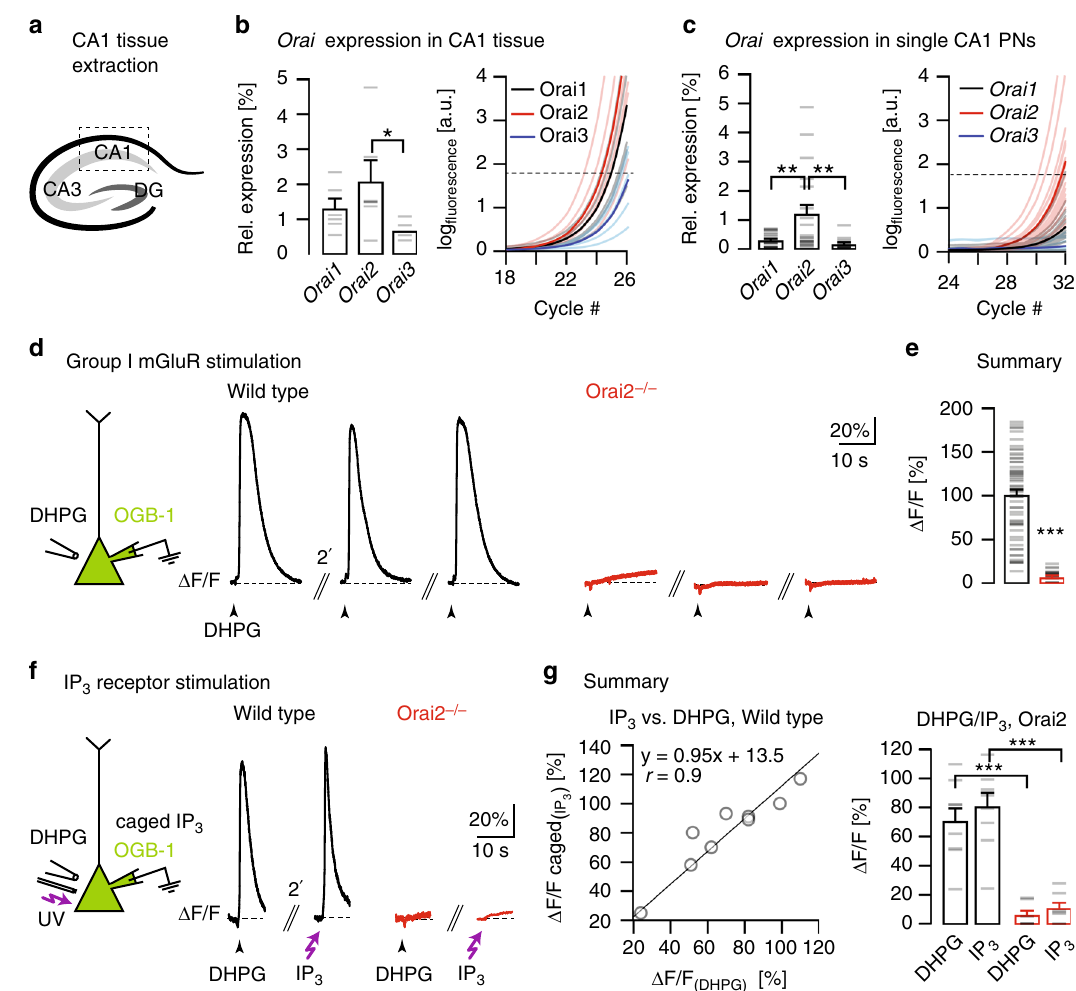
Fig. 1 Orai2 is required for IP 3 R-dependent Ca 2 + release from internal stores. a Schematic depiction of the hippocampus with the three regions CA1, CA3, and the dentate gyrus (DG). CA1 tissue was extracted for quantitative reverse transcription-PCR. b Result of Orai PCR analysis in the mouse hippocampus (P18). Left: Mean expression levels of the three Orai homologs relative to the housekeeping gene Gapdh ( n = 6 mice, p = 0.024 (analysis of variance)). Gray dashes represent individual values in this and other fi gures. Right: Real-time monitoring of the fl uorescence emission of SYBR Green I during the PCR ampli fi cation of Orai1-3 cDNA. Dashed line: noise band. c Analogous PCR analysis in single CA1 pyramidal neurons (PNs) harvested from acute hippocampal slices. Orai1: n = 21, Orai2: n = 19, Orai3: n = 15 cells; p = 0.002 (Orai1 – Orai2), p = 0.001 (Orai2 – Orai1). d Left: DHPG was pressure-applied to somata of whole-cell patch-clamped CA1 PNs fi lled through the patch pipette with OGB-1. Black traces: Ca 2 + transients in CA1 PNs in a wild-type mouse (left) in response to repeated applications of DHPG (500 µ M, 200 ms) at 2-min intervals. Red traces: Analogous experiments in an Orai2 − / − mouse. e Mean amplitudes of DHPG-evoked Ca 2 + transients in wild-type and Orai2 − / − mice ( n = 62 and 33 cells, respectively; p = 9.84 × 10 − 24 ). f Left: Both ultraviolet light pulses and local DHPG puffs were applied to somata of whole-cell patch-clamped CA1 PNs fi lled with OGB-1 and NPE ( “ caged ” )-IP 3 through the patch pipette. Black traces: Fluorescence transients resulting from photolysis of caged IP 3 (left) and local DHPG puff application (right) in the same cell in a wild-type mouse. Red traces: Analogous experiment in an Orai2 − / − mouse. g Left: Correlation plot of relative fl uorescence changes in response to IP 3 -uncaging ( y axis) against relative fl uorescence changes in response to DHPG applications ( x axis) in the same cells in the wild type. Right: Mean amplitudes of relative fl uorescence changes in response to both treatments in c in both genotypes ( n = 9 cells in wild type and 7 cells in Orai2 − / − mice, p = 1.74 × 10 − 4 , p = 3.5 × 10 − 4 ). * - signi fi cant ( p < 0.05), ** - very signi fi cant ( p < 0.01), *** - highly signi fi cant ( p <